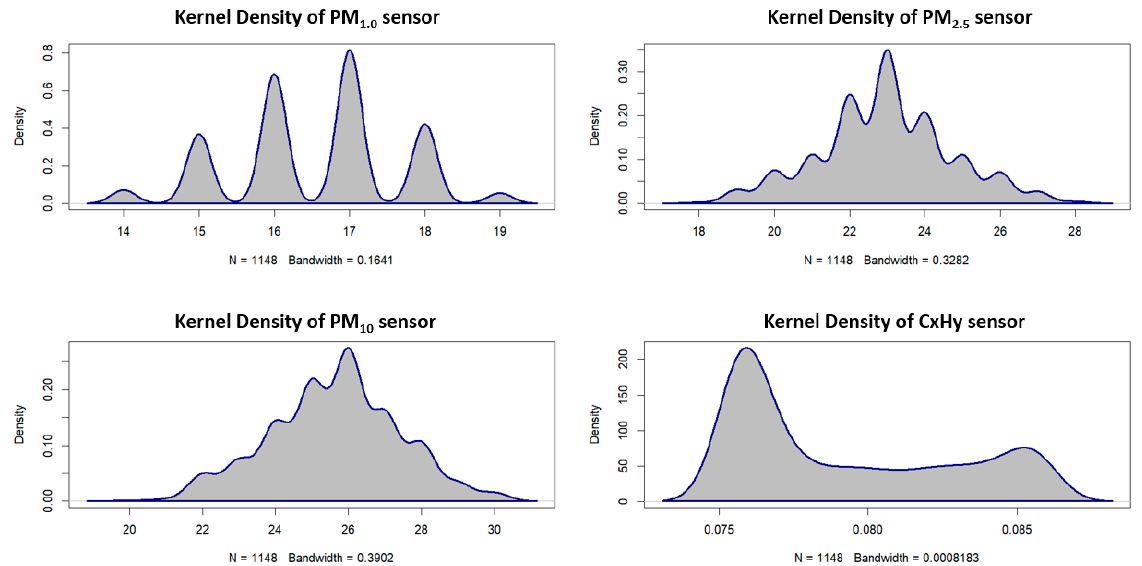
Figure A2. Kernel density for first ground measurement (PM 1.0 sensor, PM 2.5 sensor, PM 10 sensor, C X H Y sensor).